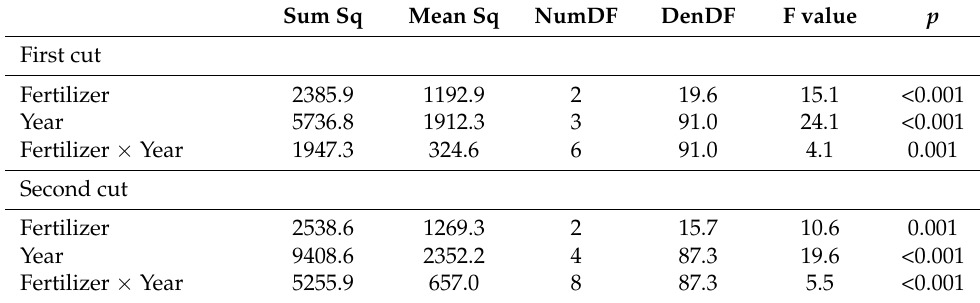
Table 3. Effects of fertilizer and year on the crude protein of the first cut in early June and the second cut in mid-August according to the minimal adequate model. Both models had three levels for the fertilizer, for the first cut four levels for year, and for the second cut five levels for year (Figure 1). Sum